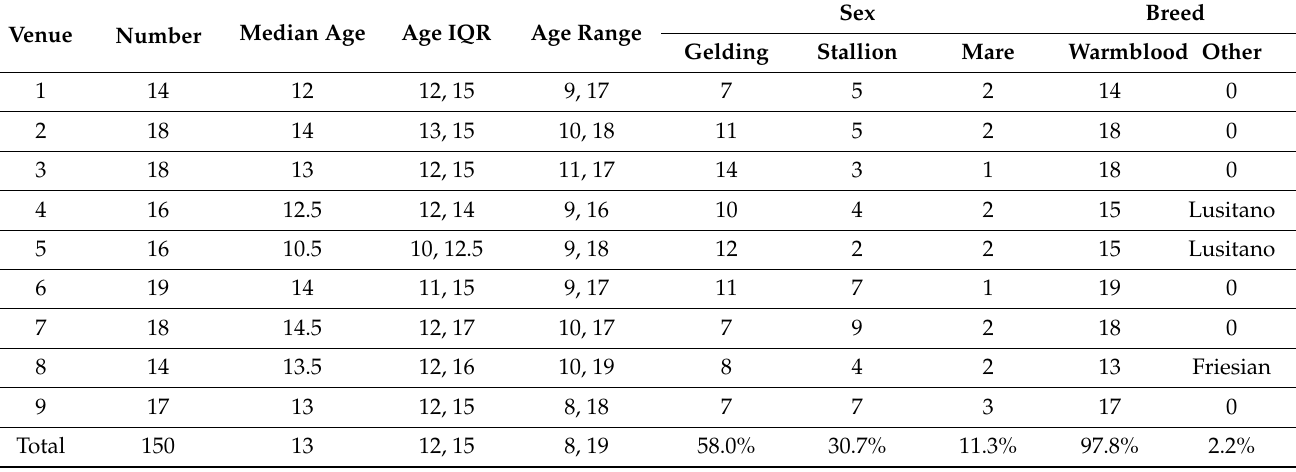
Table 2. Summary of age in years (median, interquartile range (IQR) and range), sex, and breed data for 150 competitors competing at nine venues at World Cup Grand Prix dressage Western European qualifying competitions ( n = 7) and two World Cup Grand Prix dressage finals, 2018–2020. The data for 27 horses which competed at least two or more venues are included.